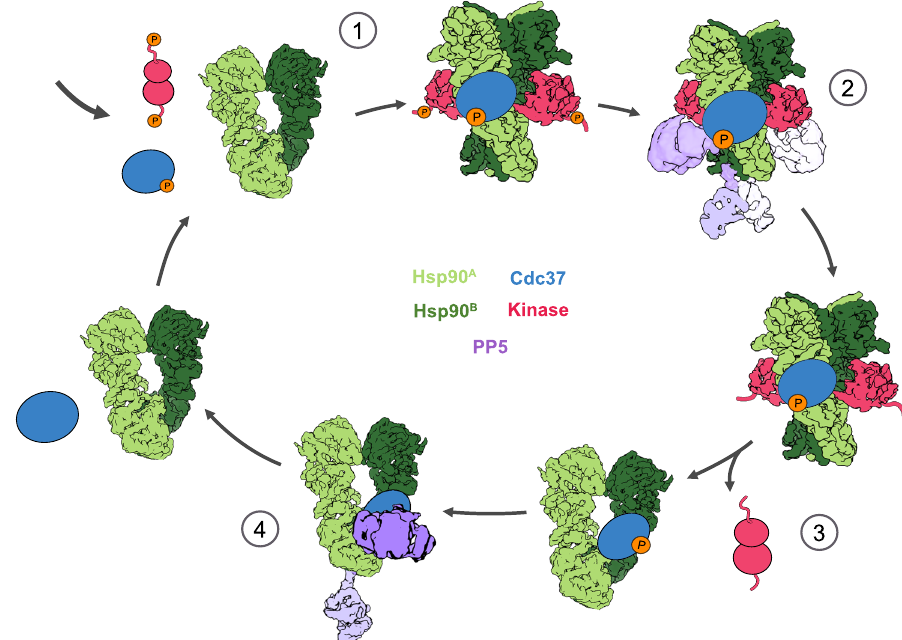
Fig. 6 | Model of PP5 ’ s role in kinase and Cdc37 dephosphorylation. Steric blocking ofCdc37 pS13 dephosphorylation by kinase clients suggests thatCdc37can only be dephosphorylated once the kinase has exited the Hsp90 complex. Our modelgoes asfollows: (1) Cdc37 pS13 fi rst recruits the kinase to Hsp90 forfolding or modi fi cation. (2) PP5 can then dephosphorylate CRaf, binding to Hsp90 in